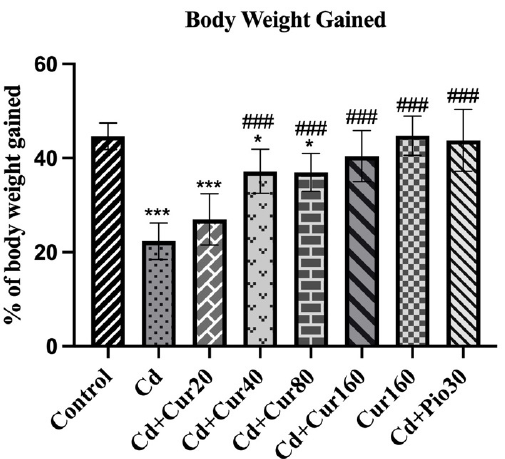
Figure 2. Effect of curcumin on Cd exposed mice exhibiting % body weight gained during the experiment. Each column represents the mean ± SEM of 7 animals. One-way ANOVA followed by Dunnett’s post-test; * p < 0.05 and *** p < 0.001 showing significant differences between control and treatment group. ### p < 0.001 showing significant differences between Cd exposed group and curcumin treated groups.